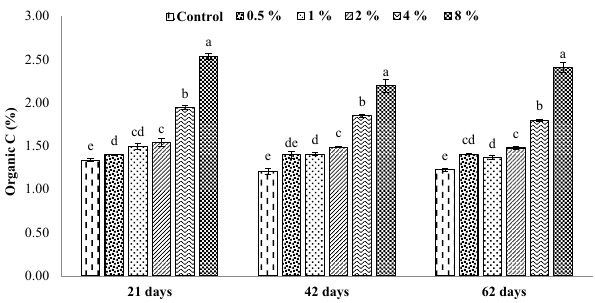
Figure 5. Effects of different rates of SMC application on soil or- ganic carbon (mean ± SD<0.05). Means followed by the same let- ter are not statistically different as determined by a least significant difference test.